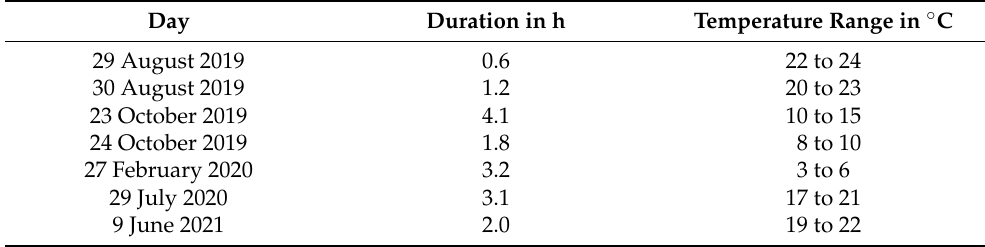
Table 2. Measurement campaigns at Seßlach, Germany.